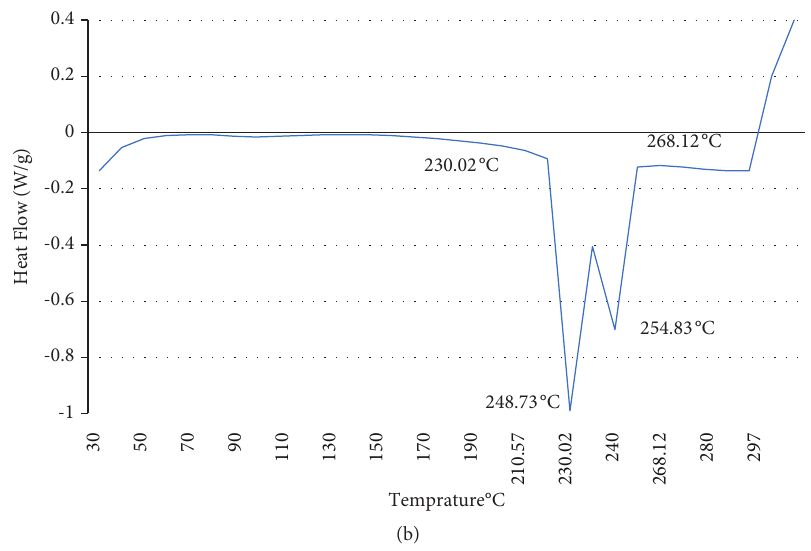
Figure 3: The DSC heating scan of (a) recycled PET and (b) nanocomposite